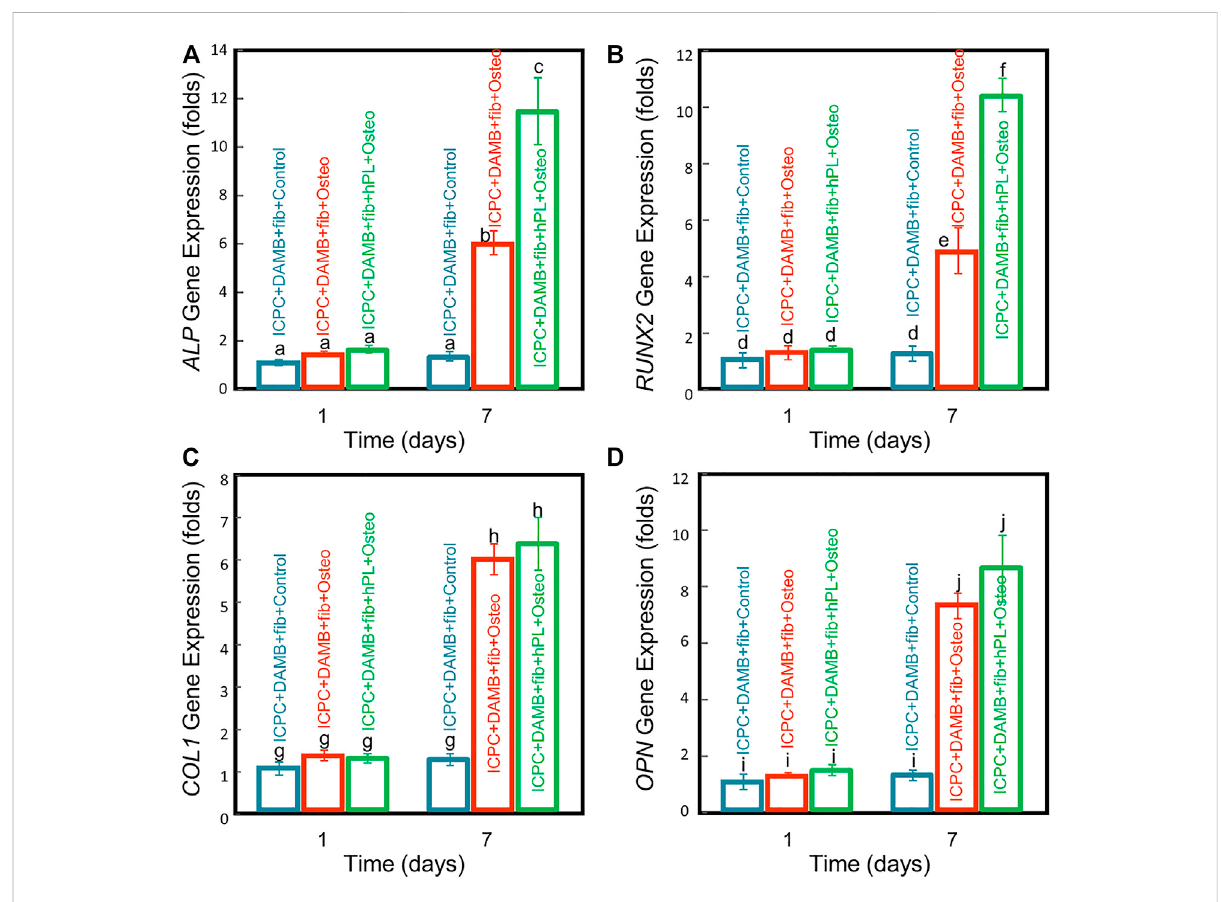
FIGURE 5 qRT-PCR assay of osteogenic differentiation of hPDLSC-microbeads co-cultured with ICPC scaffolds for 1 and 7 days: (A) ALP , (B) RUNX2 , (C) COL1 , and (D) OPN gene expressions ( n = 5). Values with dissimilar letters are signi fi cantly different from each other ( p <